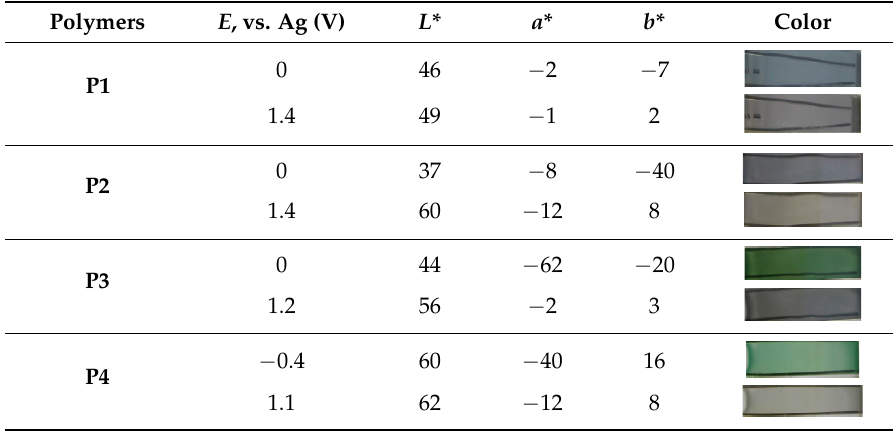
Figure 10. Transmittance change of the polymers with a same residence time of 4 s: ( a ) P1 monitored at 375, 615 and 1500 nm; ( b ) P2 monitored at 415, 556 and 1550 nm; ( c ) P3 monitored at 408, 830 and 1630 nm; and ( d ) P4 monitored at 422, 754 and 1660 nm. First of all, no distinct loss emerged during the persistent square wave potential scanning for 300 s, which could indicate the favorable stabilities of the polymer films. Transmittance change ( T %), also defined as optical contrast, was determined as 7.0% at 375 nm, 11.1% at 615 nm and 50.0% at 1500 nm for P1, and the numerical values of P2, P3 and P4 are all listed in Table 4. As expected, all four polymers had higher T % values in the NIR region than that in the visible region, particularly for P4 with a conspicuous 80% contrast at 1660 nm. Table 4 also lists the switching properties of other D-A type polymers, from which it can be seen that the polymers reported in the present manuscript had competitive switching performance, especially in the NIR region, showing fascinating candidates in the application of NIR electrochromic devices.